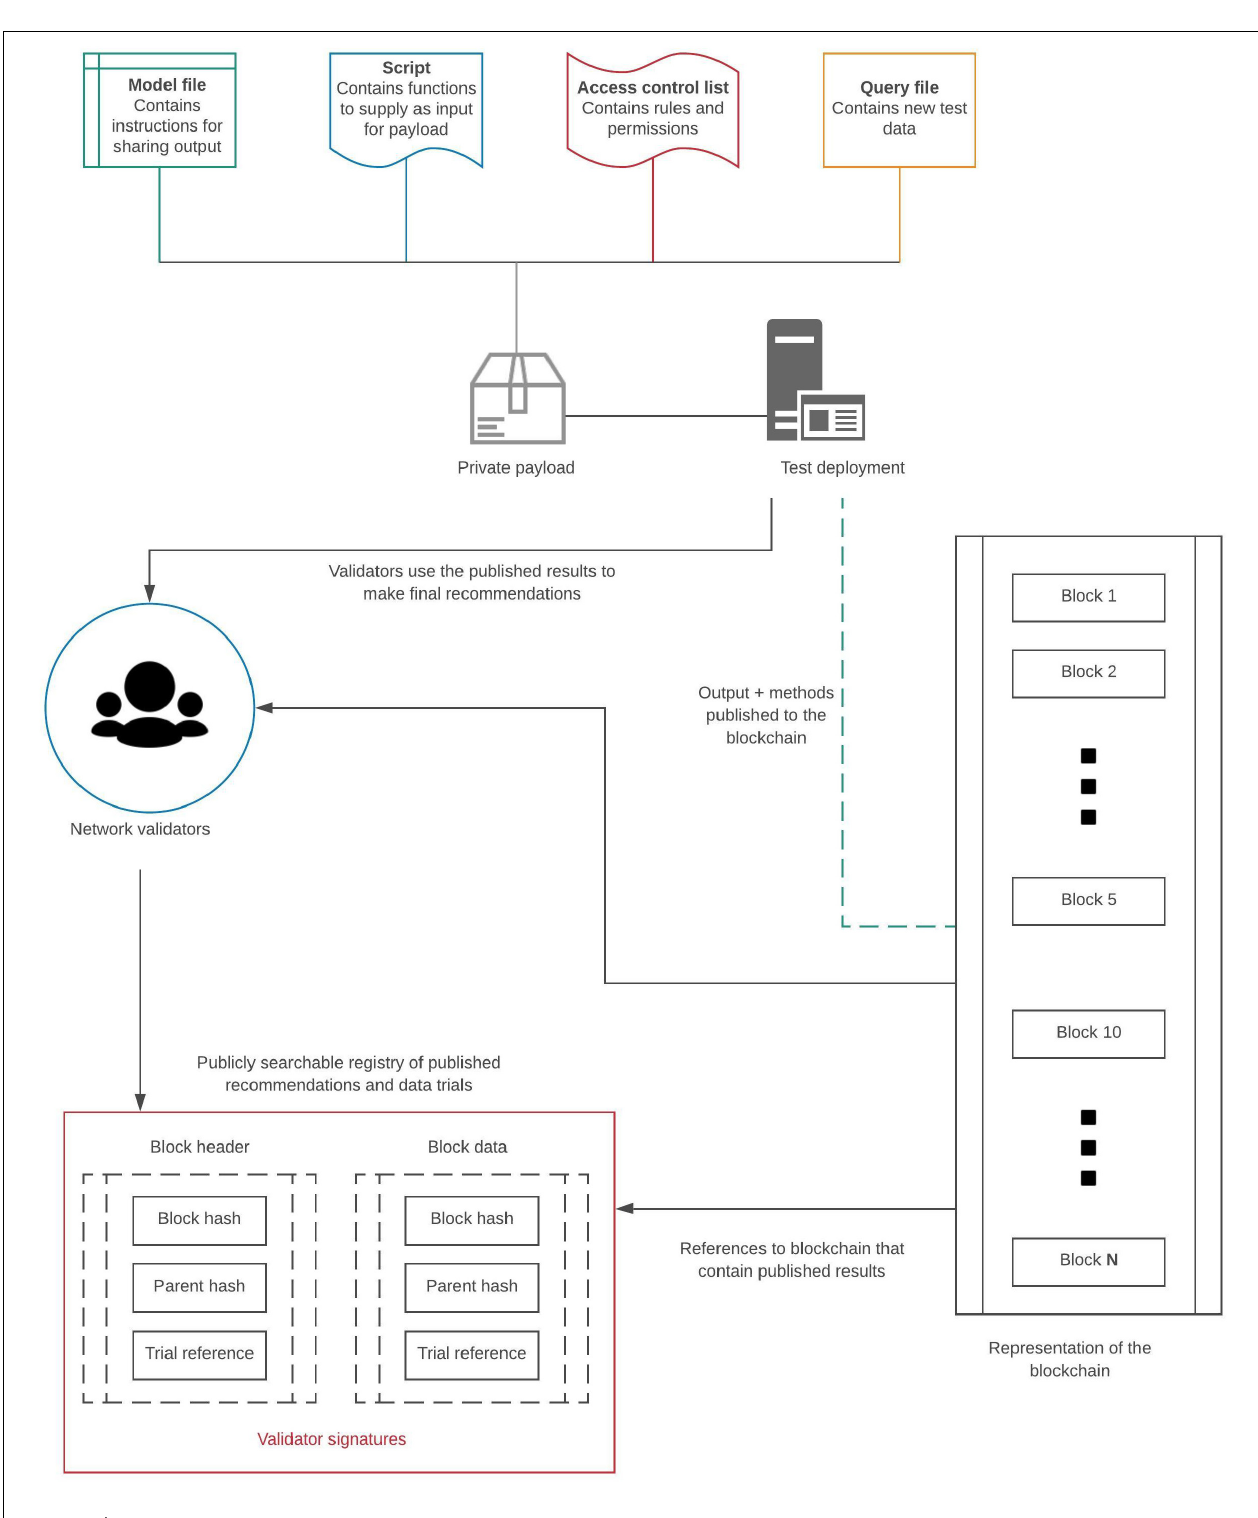
Frontiers in Blockchain |